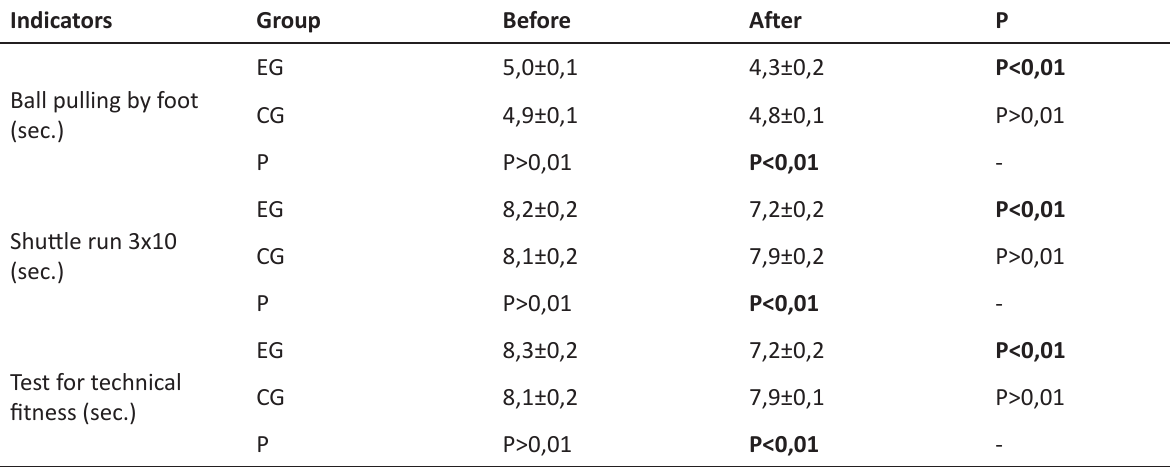
Table 1. EG and CG students’ indicators from the beginning and up to the end of experiment